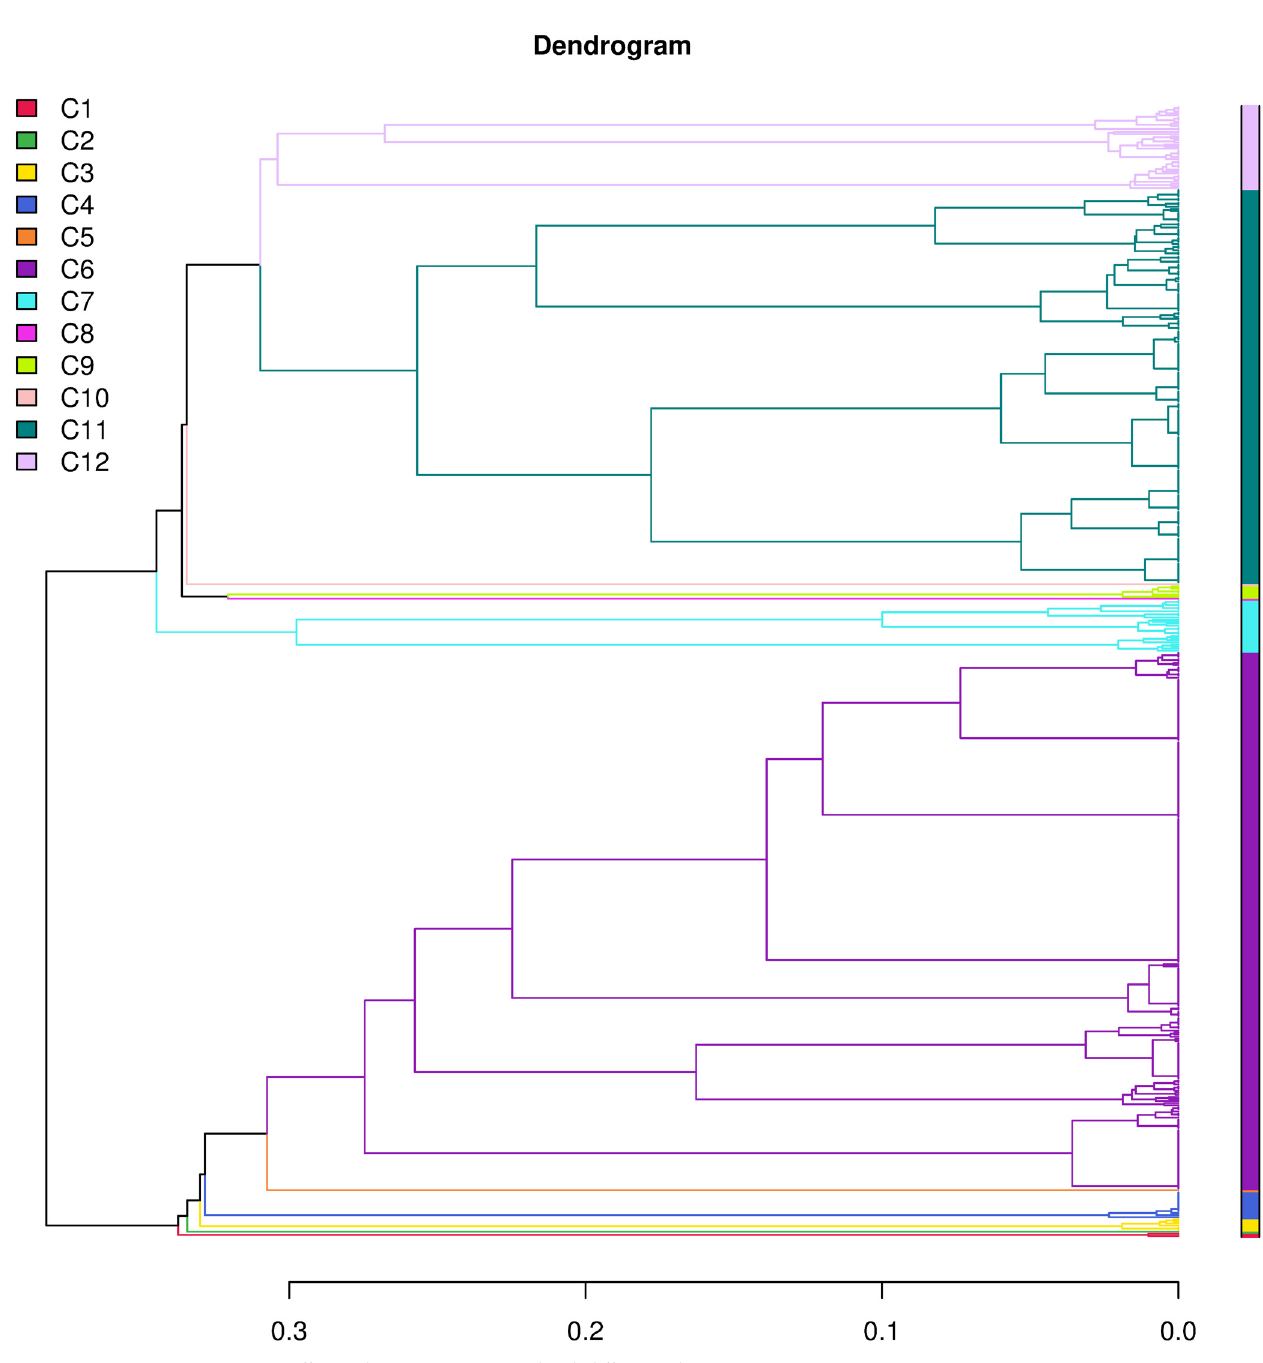
Fig 7. Dendrogram for group 2. Different clusters are represented with different